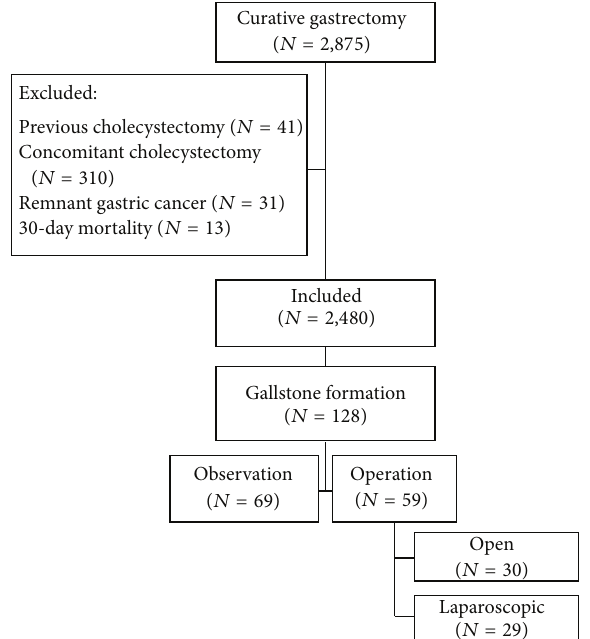
Figure 1: Patient enrollment and